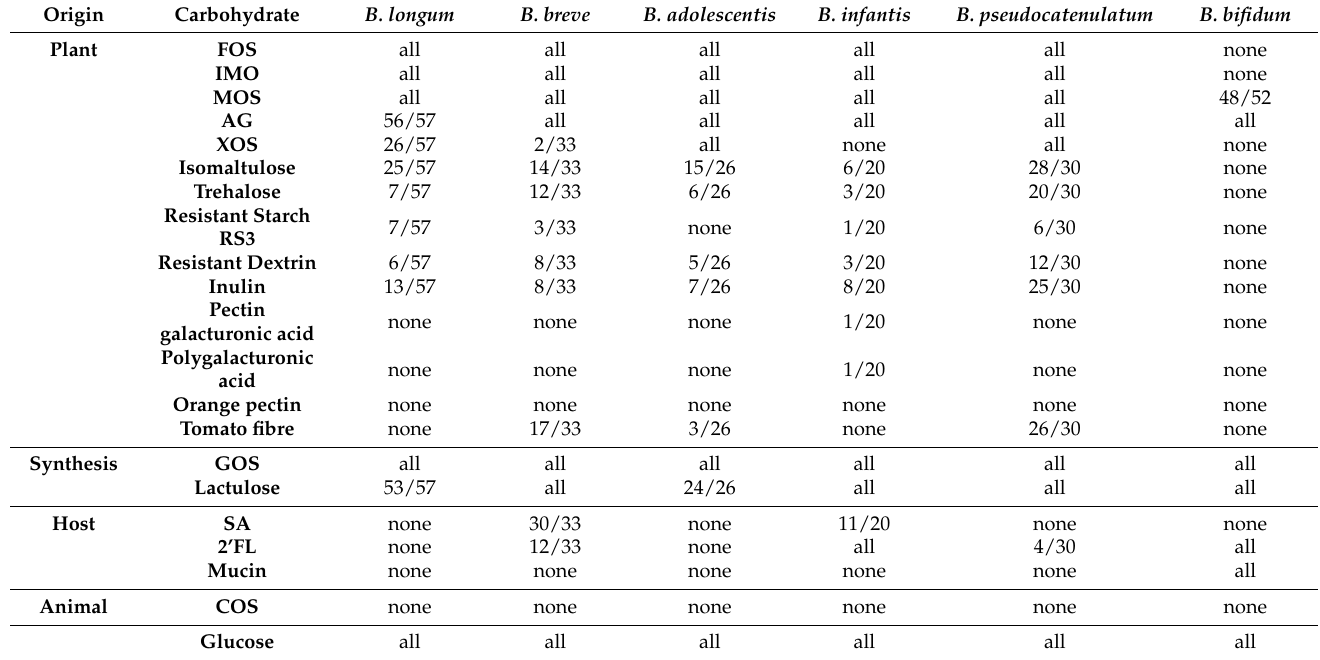
Table 1. Utilization of carbohydrates by